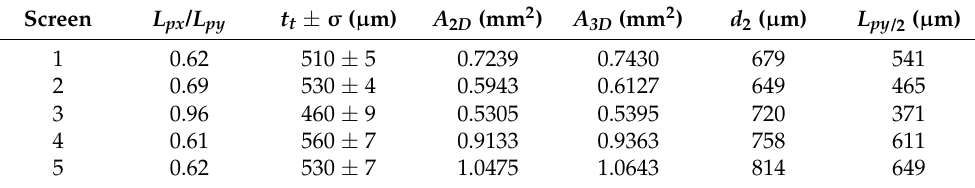
Table 3. Shape factor L px / L py ; textile thickness t t ; surface area of the holes measured in